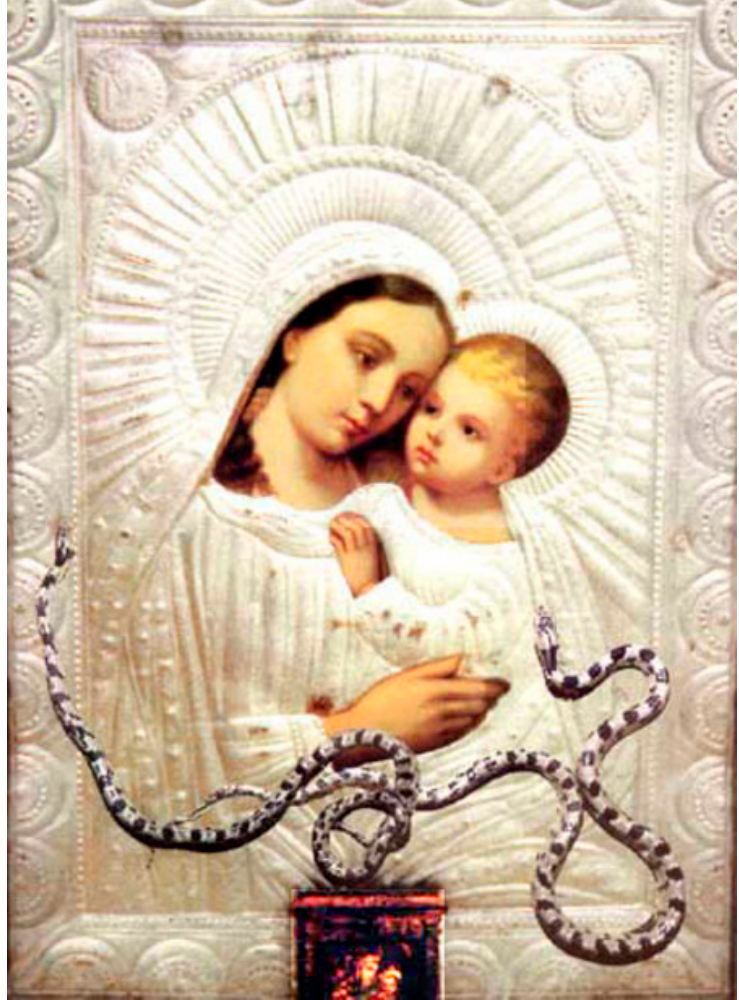
Figure 3. Panaghia Feduosa (Virgin of Snakes), Kellafonia, Greece.